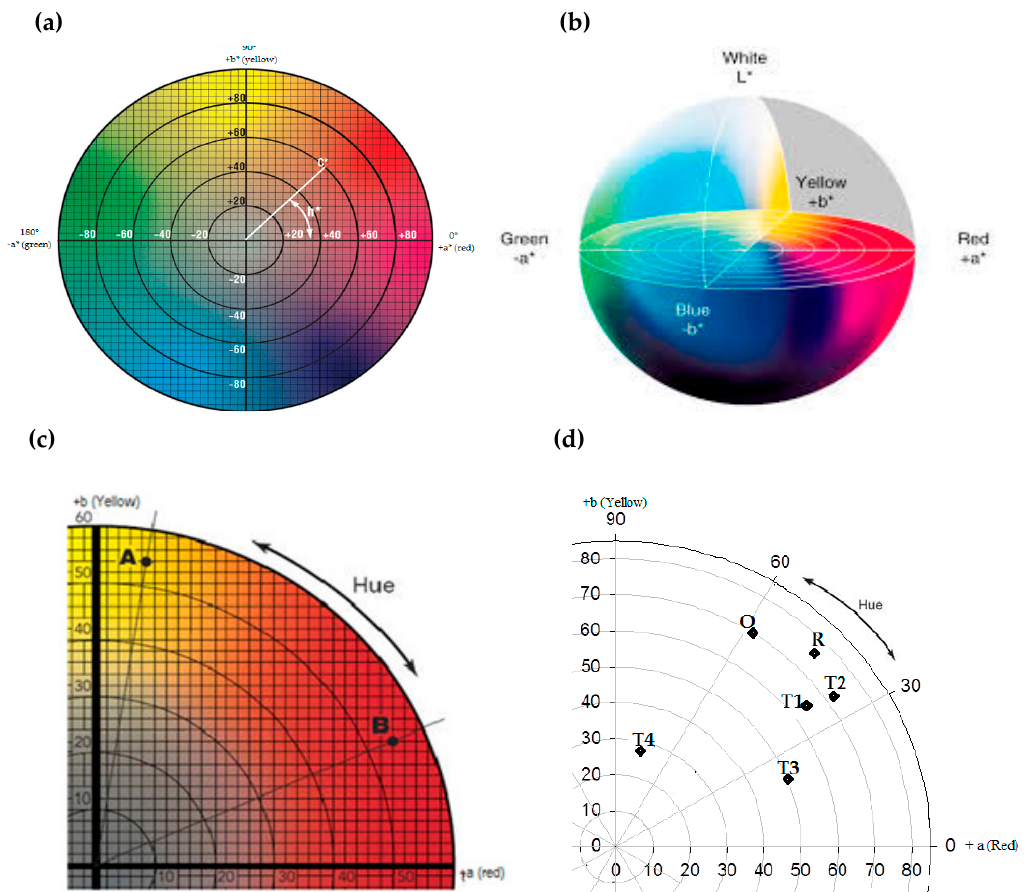
Figure 7. ( a ) CIE L * a * b * chromaticity diagram (Konica Minolta precise color communication). ( b ) Two dimensional L * a * b * model from CIE L * a * b * color space. ( c ) Representation of CIE L * a * b * colorimetric system showing the hue angles ( h ◦ ). ( d ) Polar scatter plot showing the positions of pigments of T. albobiverticillius 30548 cultured in four different sea salt concentrated media: T1 (0%), T2 (3.65%), T3 (6%), T4 (9%) including reference standards, quinizarin (O) and Monascus red rice (R).